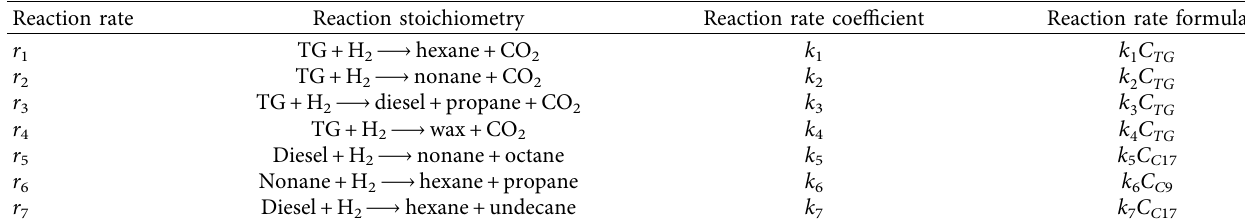
Table 2: Hydrocracking reactions and their reaction rate coefficients’ formula.